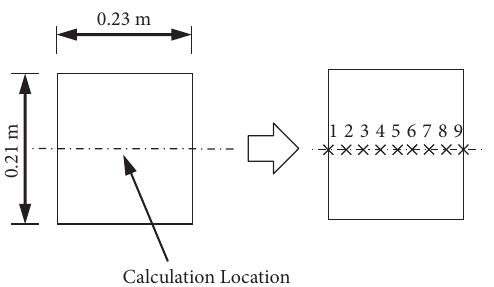
Figure 8: Schematic diagram of mesh division.